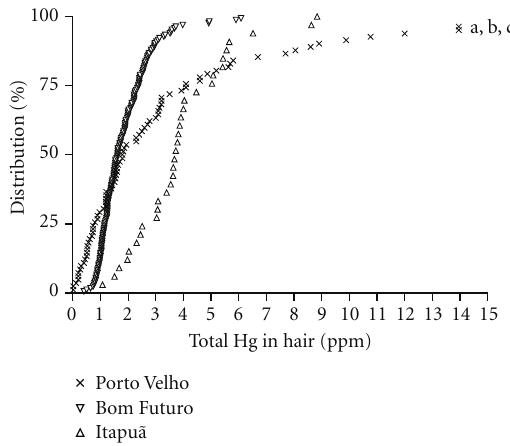
Figure 1: Cumulative percent distribution of total hair Hg concentrations in infants from di ff erent localities and maternal fish- eating habits; a, b, c are o ff -chart values of Porto Velho infants’ HHg concentrations, respectively, of 18.3, 26.8, 32.9